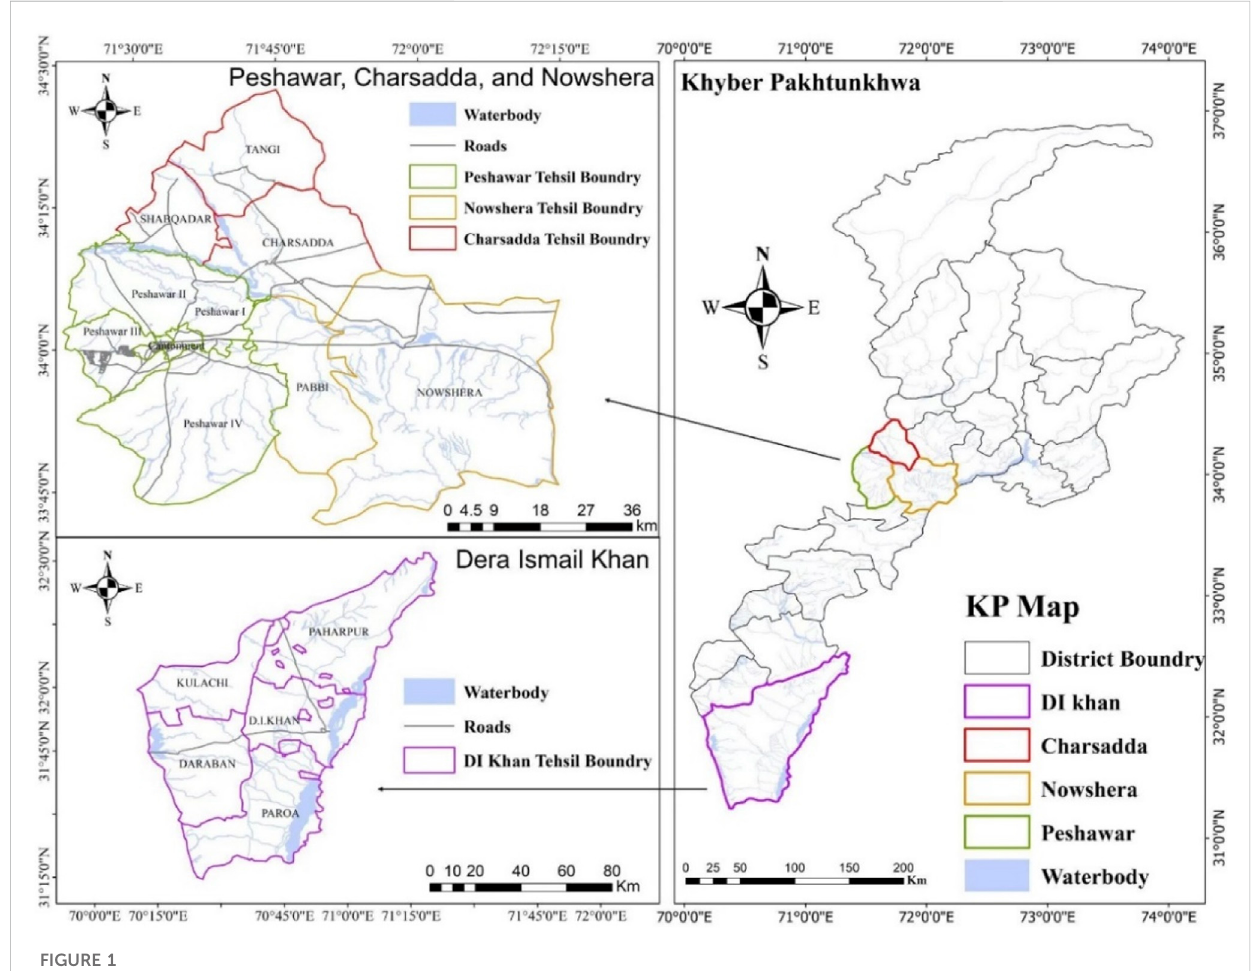
FIGURE 1 Sample study districts in Khyber Pakhtunkhwa Province,